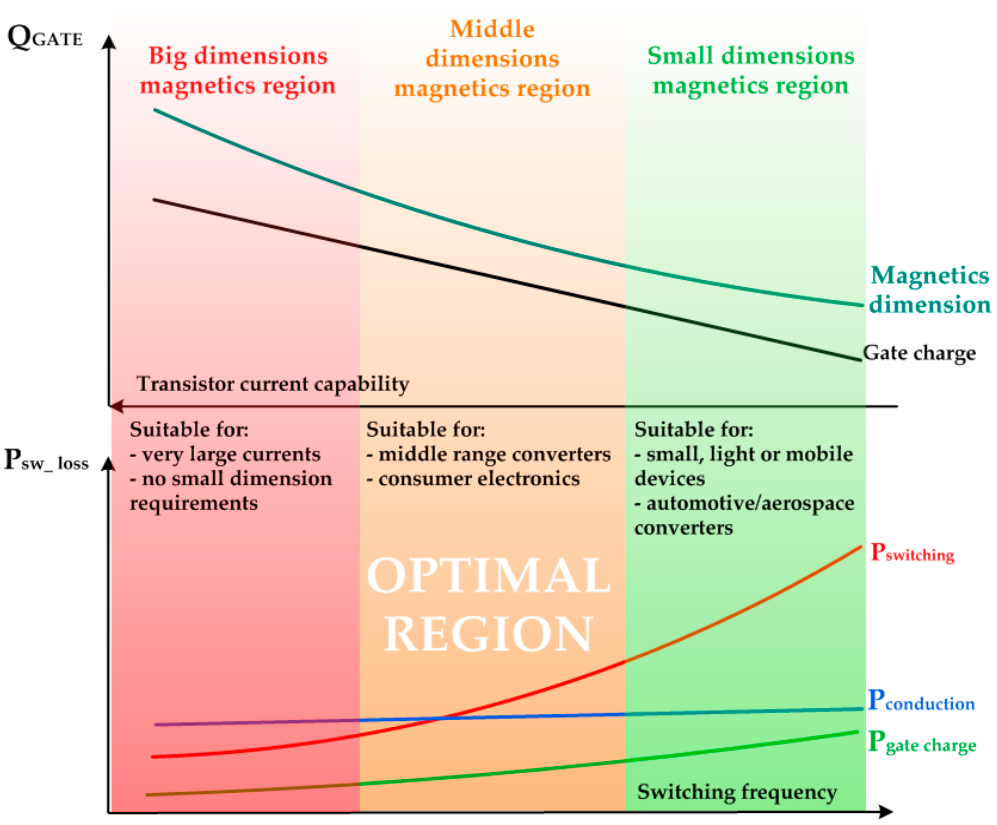
Figure 17. Graphical interpretation of power transistor performance dependencies.